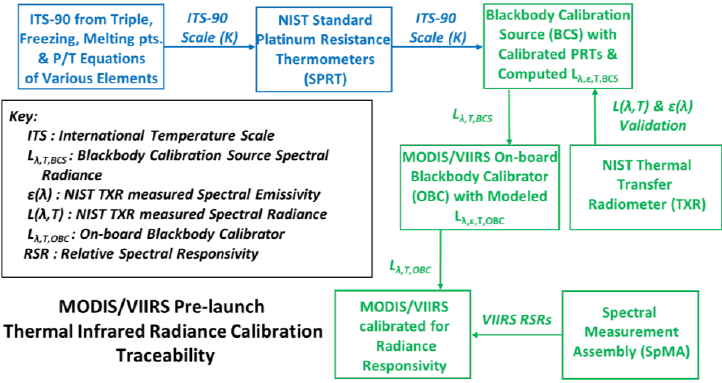
Figure 6. MODIS and VIIRS thermal infrared radiance calibration traceability.